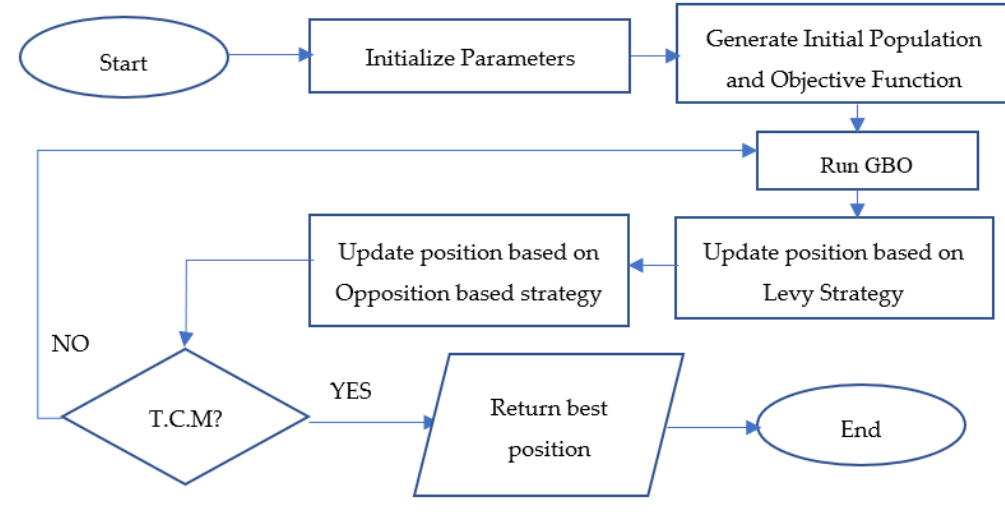
Figure 1. Flowchart of the LE-OB-GBO.